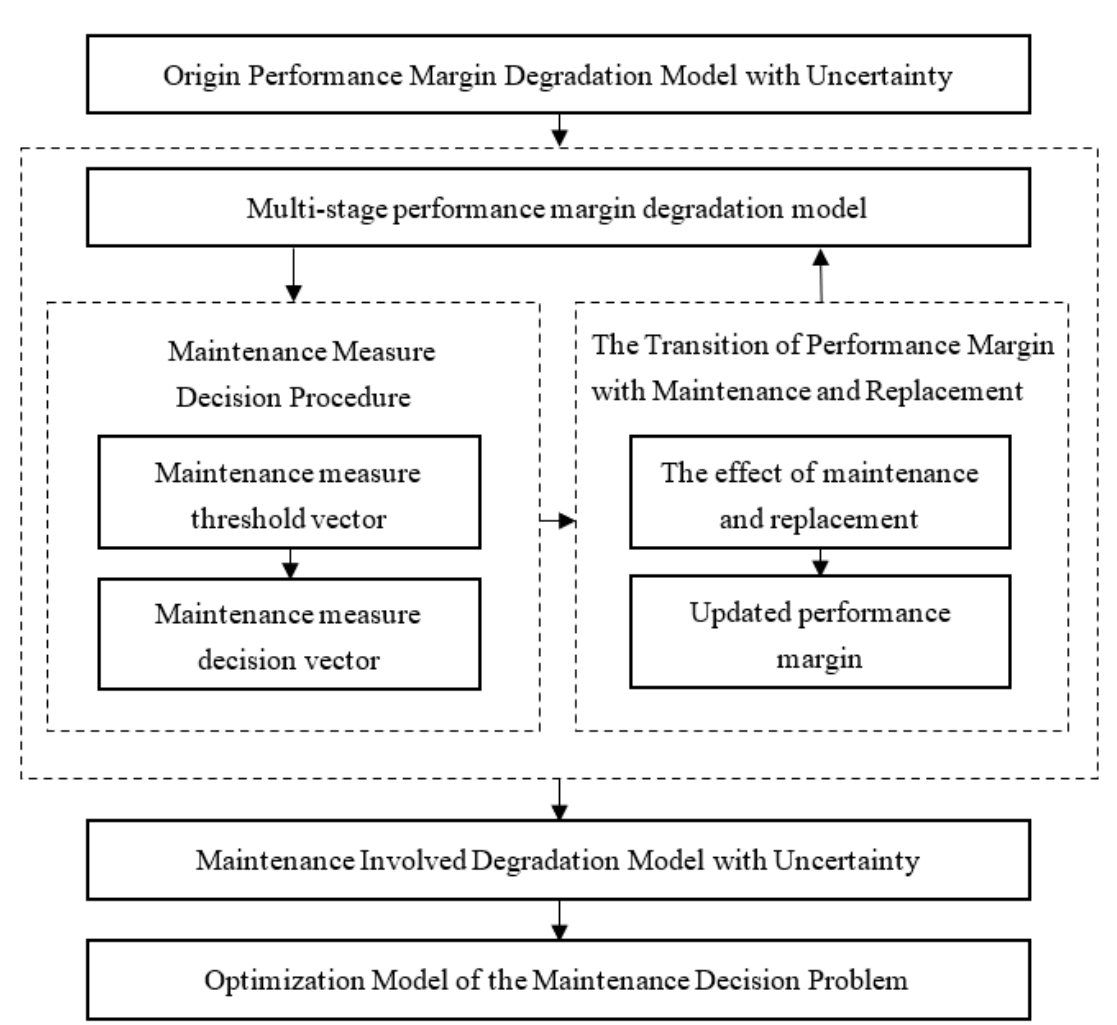
Figure 1. Framework of the proposed condition-based maintenance optimization method using per- formance margin.